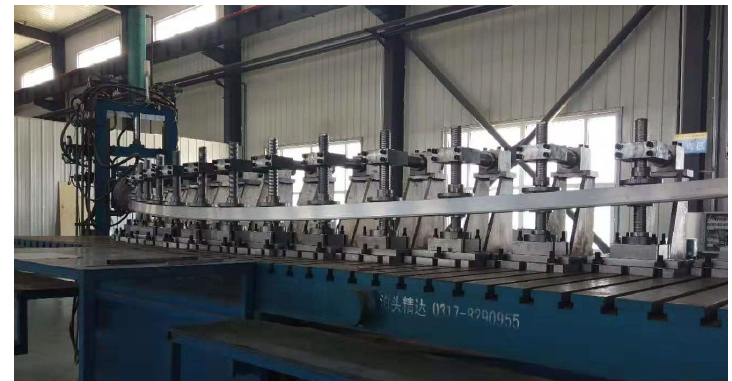
Figure 15. The FSB experiment equipment.